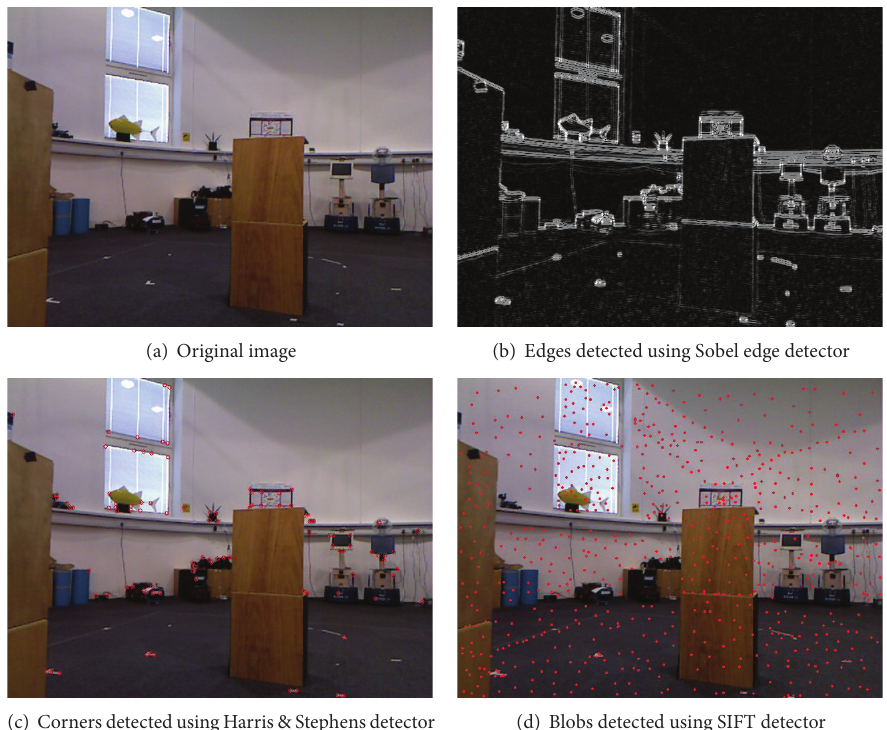
Figure 2: Results of local image feature detectors that can be used to develop a vision-based navigation system.